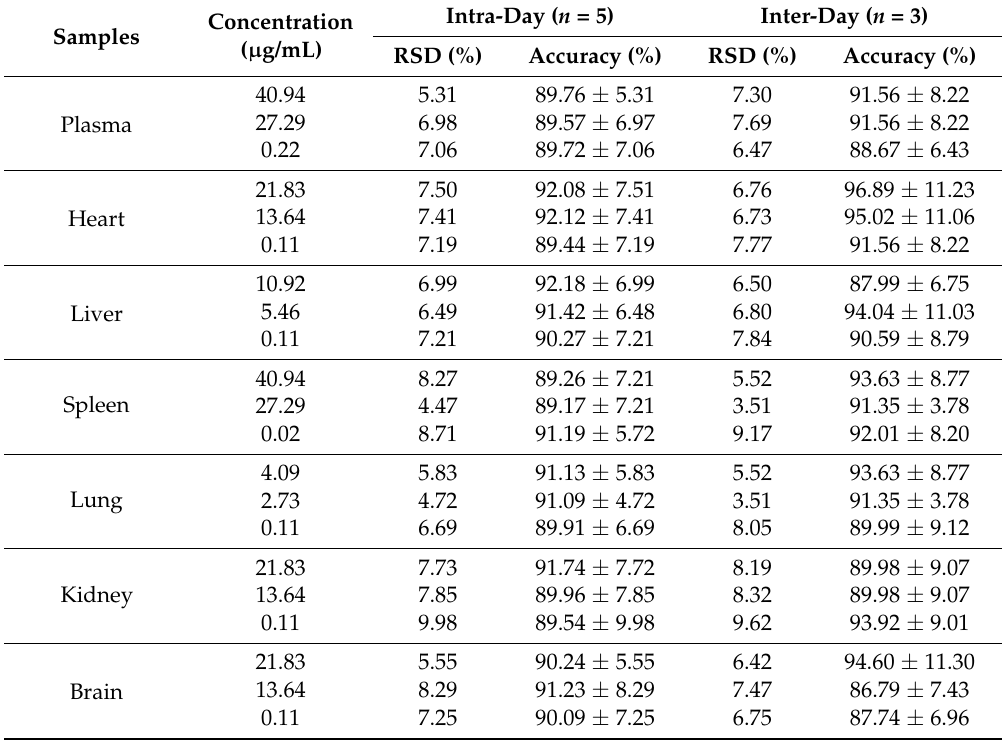
Table 2. Precision and Recovery of the baicalin in plasma and tissues in rat.